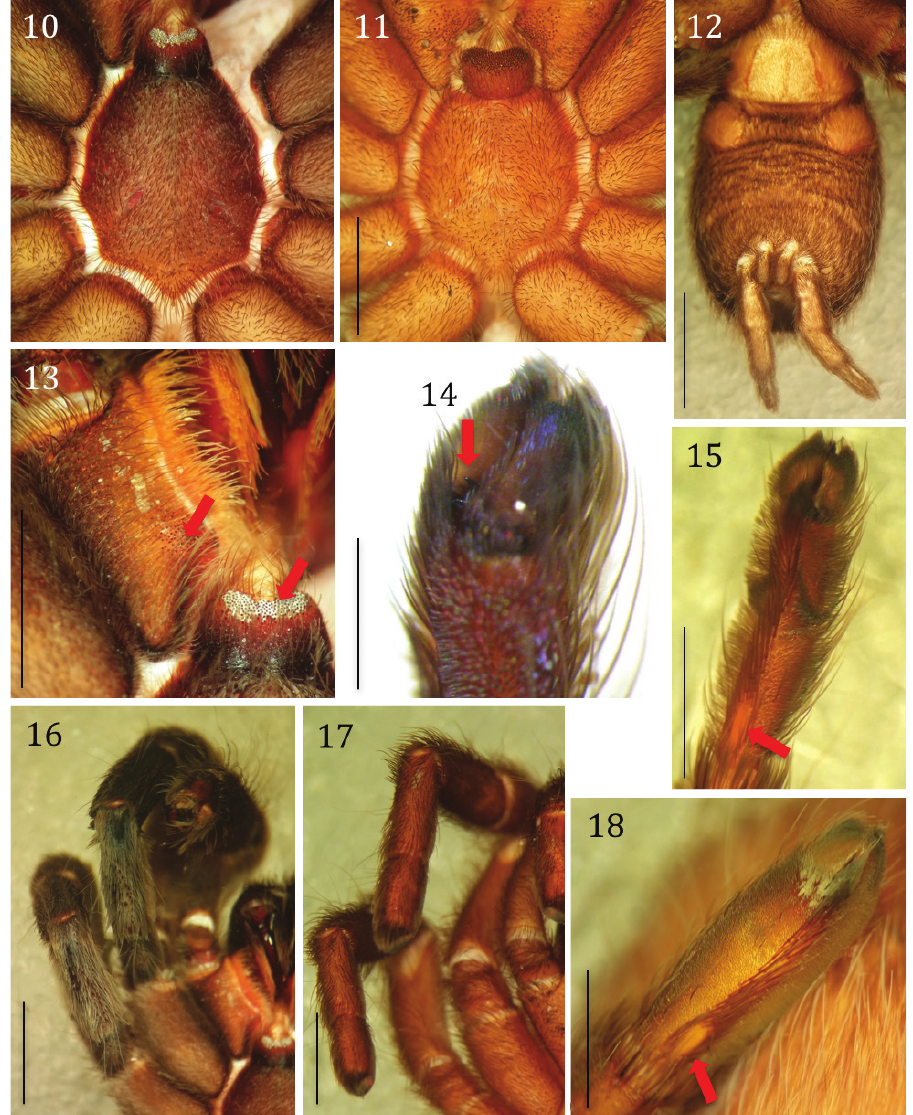
Figures 10–18. Phlogiellus longipalpus sp. n. 10, 12, 13, 15–16 holotype ♂ , CUMZ-C2-NA1: 11–17 paratype ♀ , CUMZ-C4-NA4: 14–15 paratype ♂ , CUMZ-C4-NA3 10 sternum, labium and coxae, ven- tral view 11 sternum, labium, and coxae, ventral view 12 abdomen and spinneret, ventral view 13 labium and maxilla, arrows indicate cuspules 14 left tarsus IV, ventral view, arrow indicates third claw 15 right tarsus IV, ventral view, arrow indicates “bald spot” 16 right legs I and II, dorsal view 17 right legs I and II, dorsal view 18 paratype ♀ , CUMZ-C1-NA1, left tarsus IV, ventral view, arrow indicates “bald spot”. Scale bars: 2 mm ( 10–11 ); 3 mm ( 12 ); 2 mm ( 13, 16–18 ); 0.5 mm ( 14 ); 1 mm ( 15